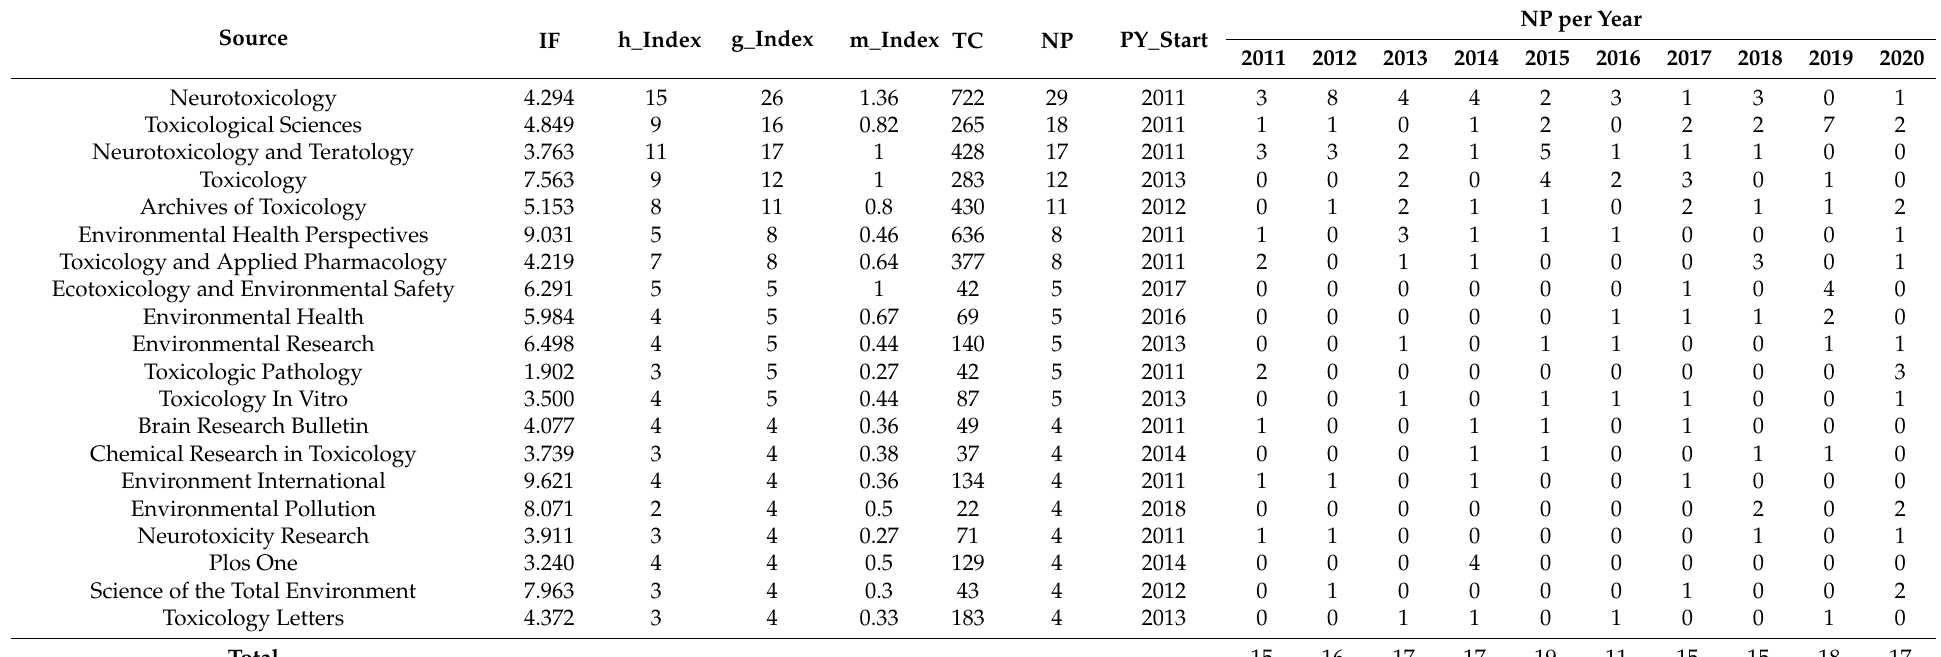
Table 4. Most relevant and impactful sources of journal articles from 2011 to